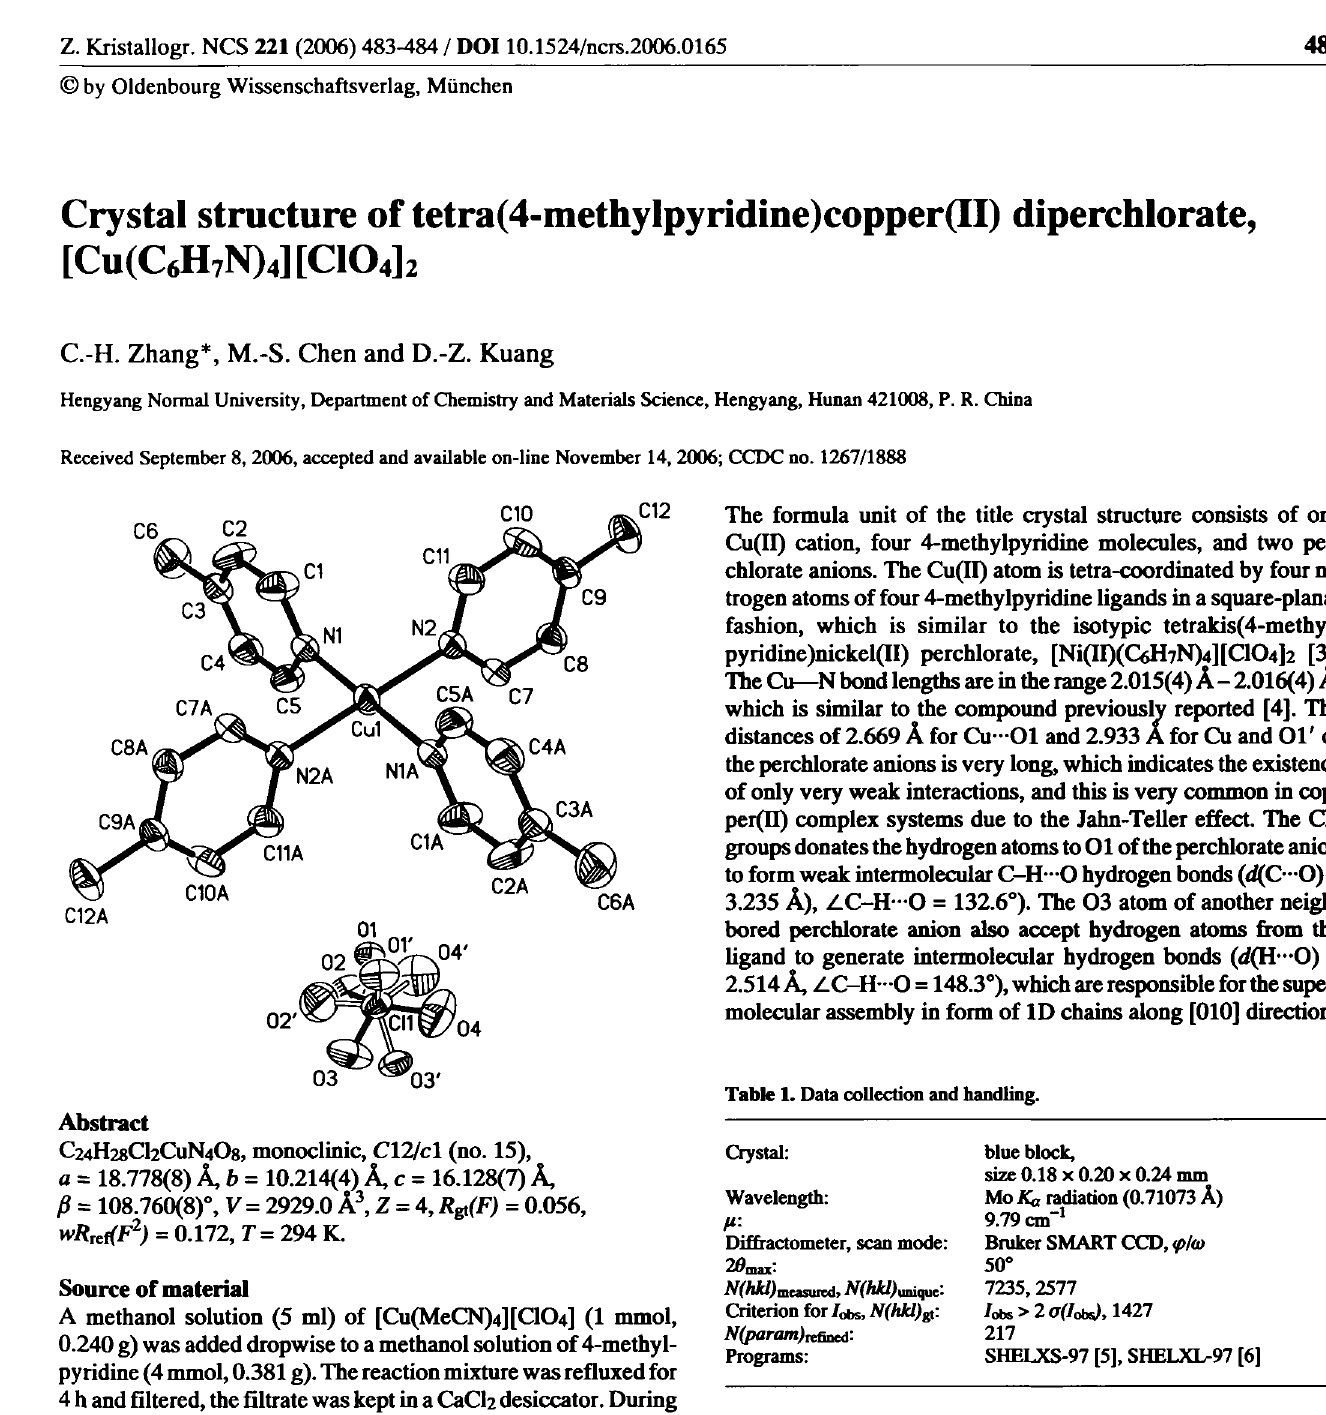
Table 2. Atomic coordinates and displacement parameters (in Ä 2